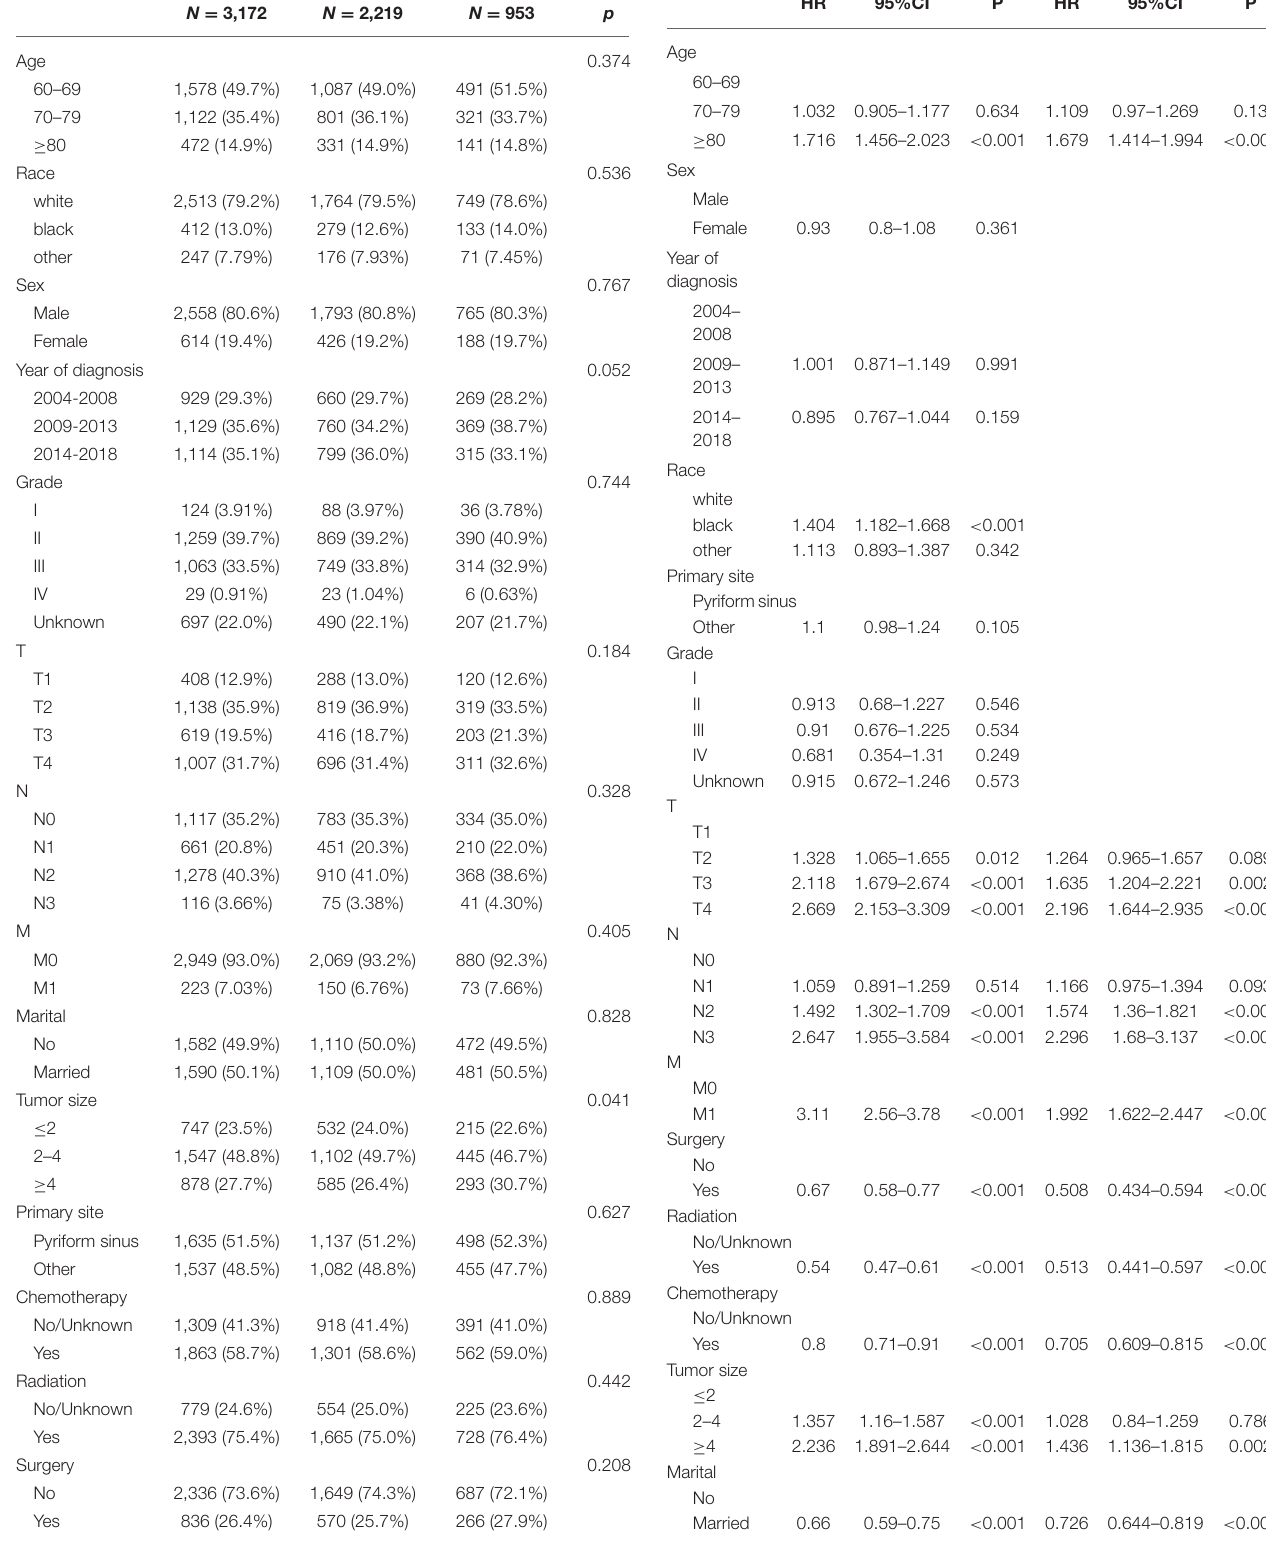
TABLE 1 | Clinicopathological characteristics of children with HPSCC. TABLE 2 | Univariate and multivariate analyses of CSS in training